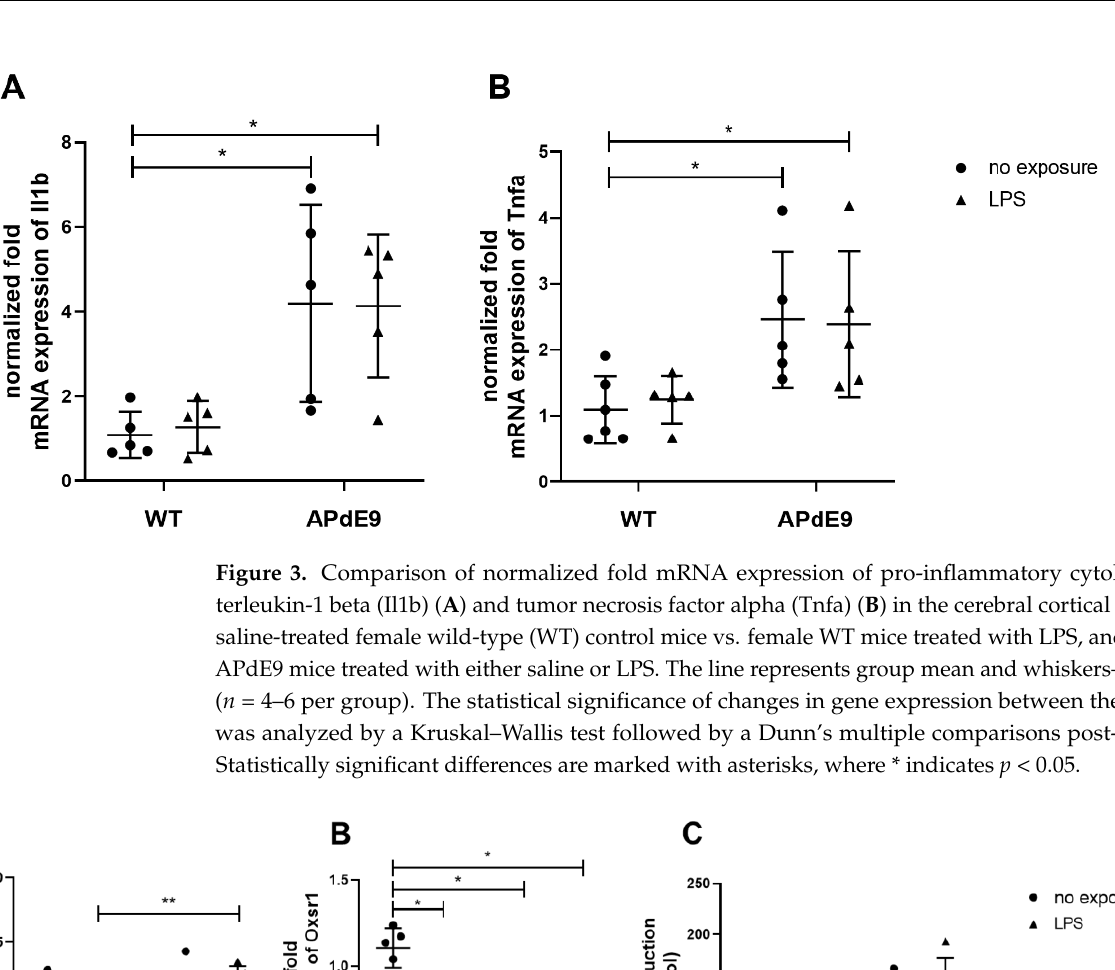
7 of 13 Figure 2. Phosphorylated /total NFκB p65 expression in the cerebral cortical tissue in saline -treated female wild-type (WT) control mice vs. female WT mice treated with LPS, and female APdE9 mice treated with either saline or LPS. The line represents group mean and whiskers — the SD ( n = 4 – 5 per group). The statistical significance of changes in gene expression between the groups was analyzed by a Kruskal – Wallis test followed by a Dunn’s multiple comparison s post-hoc test. Statistically sig- nificant differences are marked with asterisks, where * indicates p < 0.05. 3.3. Inflammatory Responses and Oxidative State in the Brain Cortices of LPS-Treated Mice The changes in gene expression of pro-inflammatory cytokines, Il1b and Tnfa, and oxidative stress markers, Sirt1 and Oxsr1, were assessed in the brain cortices of the inves- tigated mouse models using qRT-PCR (Figures 3 and 4). Kruskal – Wallis analysis revealed statistically significant differences in normalized fold mRNA expression of both pro-in-